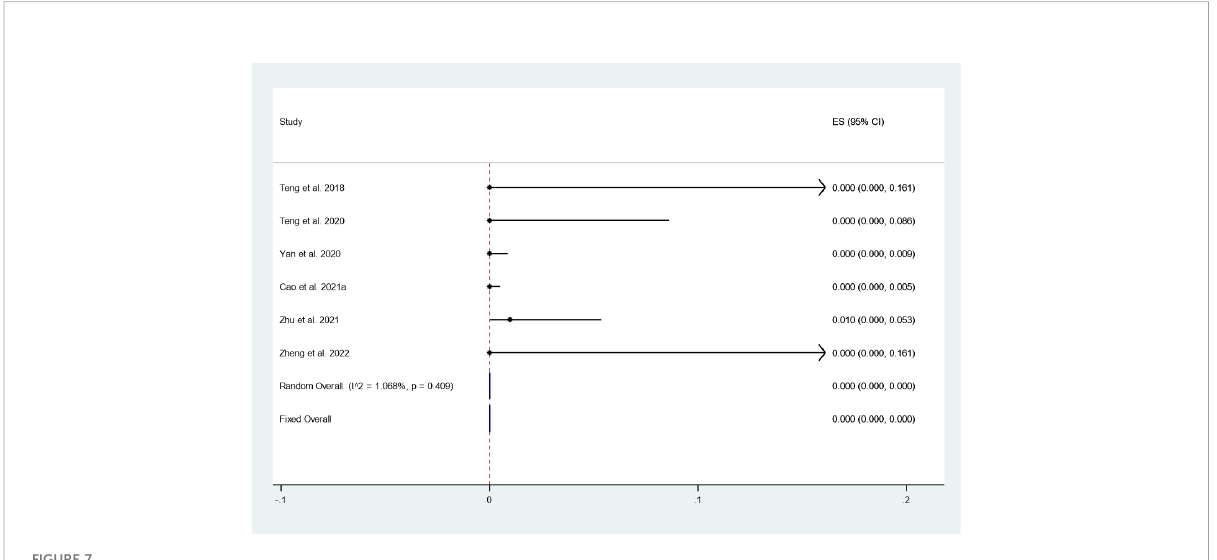
FIGURE 7 Incidence of LNM after thermal ablation at 3-year follow-up.